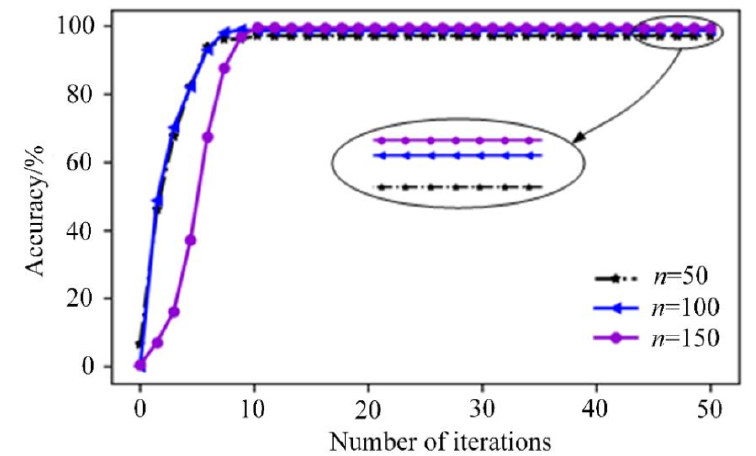
Figure 5. Change of accuracy corresponding to the number of units in different hidden